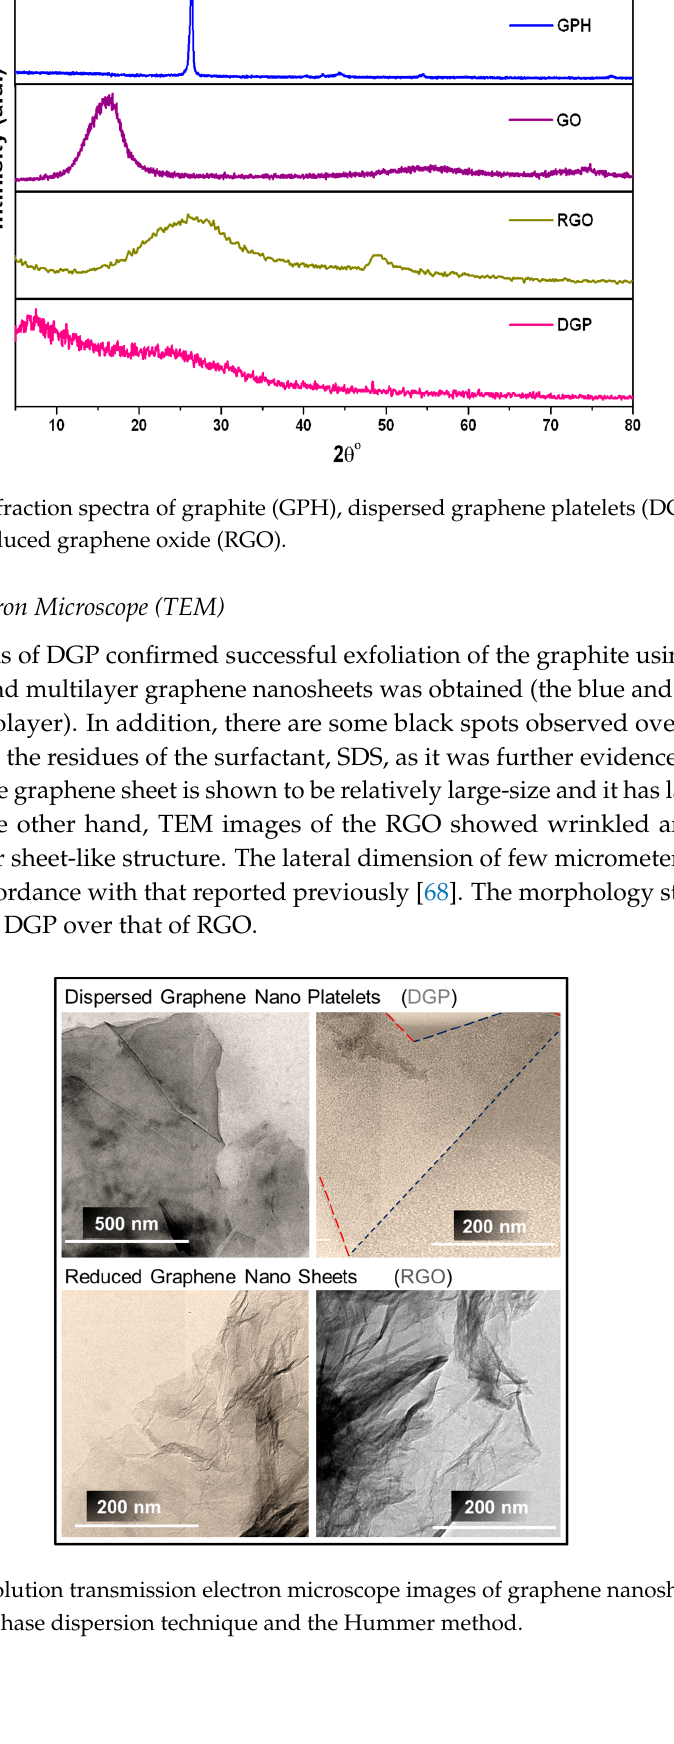
Figure 4. High resolution transmission electron microscope images of graphene nanosheets obtained with the aqueous phase dispersion technique and the Hummer method.